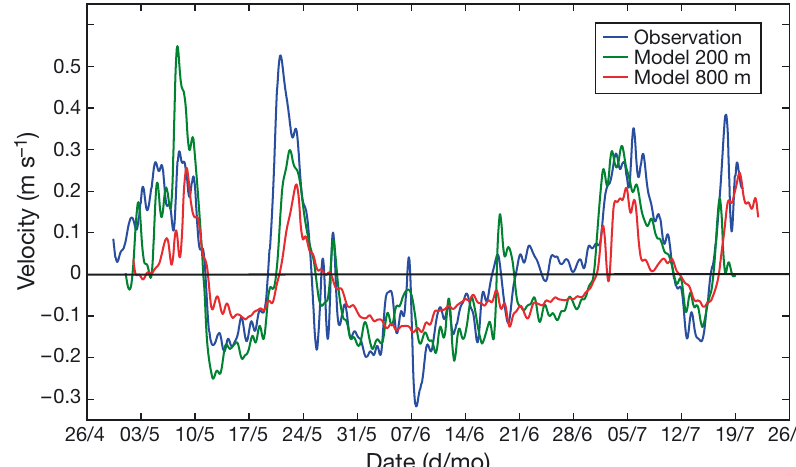
Fig. 2. Along-fjord current at 11 m depth from an observational buoy in the Hardangerfjord (blue line) and from the corresponding position in the 200 m (green line) and 800 m (red line) resolution numerical models. Positive values are currents directed towards the head of the